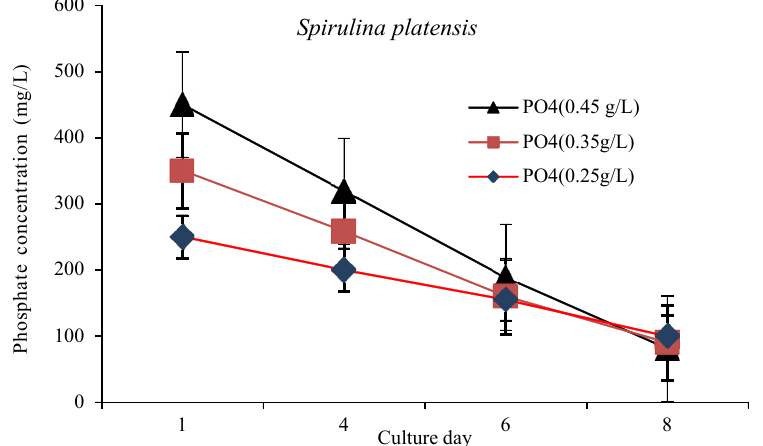
Fig. 4: Comparing the mean and standard deviation of remaining phosphate